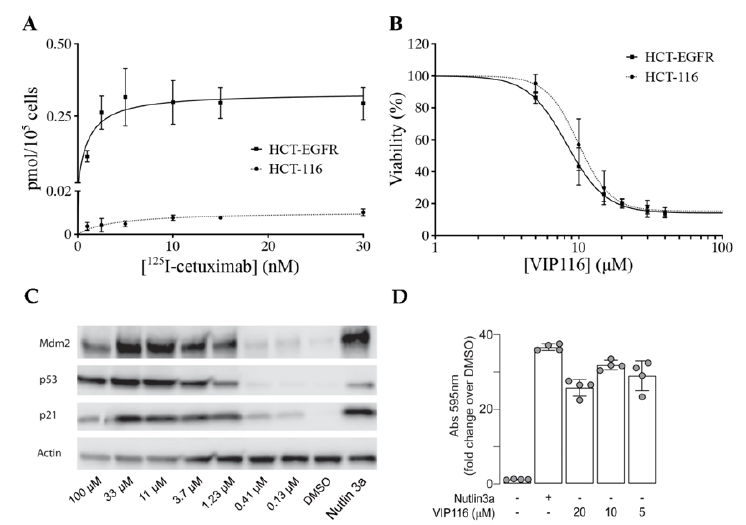
Figure 3. Characterization and validation of cell lines and VIP116. ( A ) Cellular uptake of anti-EGFR 125 I-cetuximab on HCT-EGFR (squares, solid lines) and HCT-116 (circles, dotted lines) cells, validating the increased EGFR density on HCT-EGFR cells (mean, SD. N = 2). ( B ) XTT viability assay with adjoining dose response curves after 72 h incubation with VIP116, demonstrating retained VIP116 sensitivity for HCT-EGFR cells (mean values, SD. N = 3). ( C ) Western blot analysis of HCT-116 cells, demonstrating VIP116 dose-dependent e ff ects on e.g., p53 levels. Cells were treated with either vehicle control (1% DMSO) or with a 3-fold dilution series from 100 µ M to 0.13 µ M of VIP116 for 24 h, or with 5 µ M of Nutlin 3a as a positive control. VIP116 treatments contained a residual DMSO concentration of 1% v / v DMSO. ( D ) p53 gene reporter assay, demonstrating that VIP116 induces p53 transcriptional activity. ARN8 cells stably expressing the p53 reporter RGC- ∆ Fos-LacZ were treated with DMSO, Nutlin3a (5 µ M) or VIP116 (5, 10, 20 µ M) for 18 h. Bar diagram of the mean ± standard deviation of the fold change over DMSO of the absorbance measured at 595 nm in each condition. ANOVA = 0.002. Dots represent technical replicates.